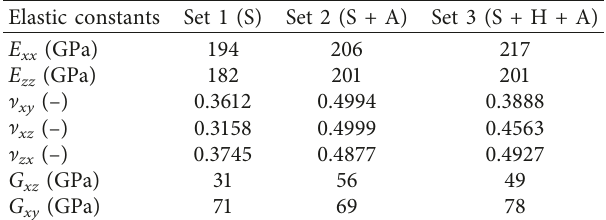
Table 10: Constants of optimized elastic